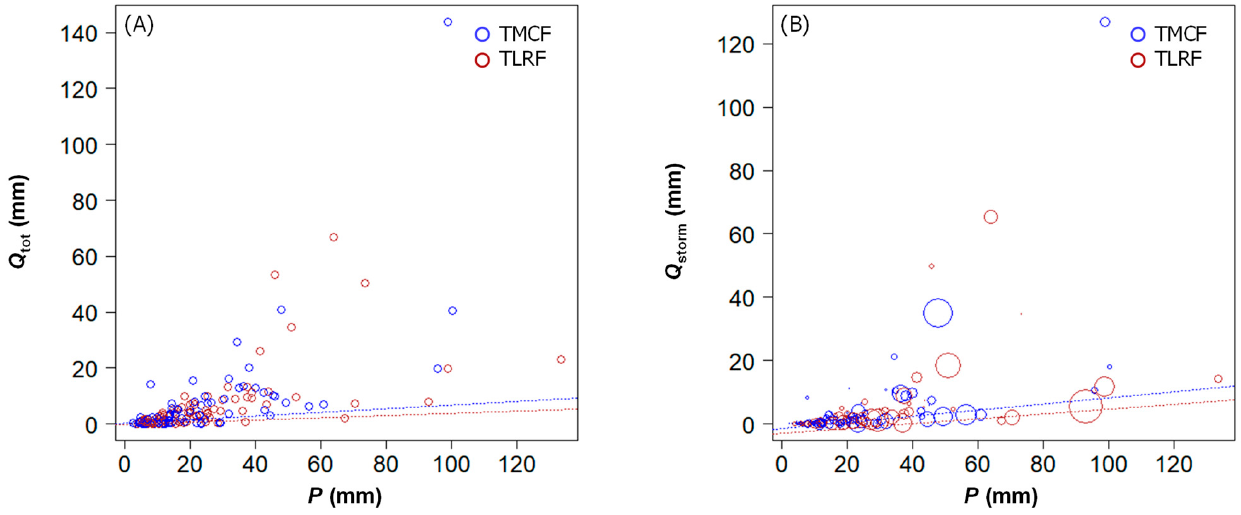
Figure 2. ( A ) Q tot and ( B ) Q storm versus event rainfall. Increasing point size in ( B ) corresponds to increasing Pi.